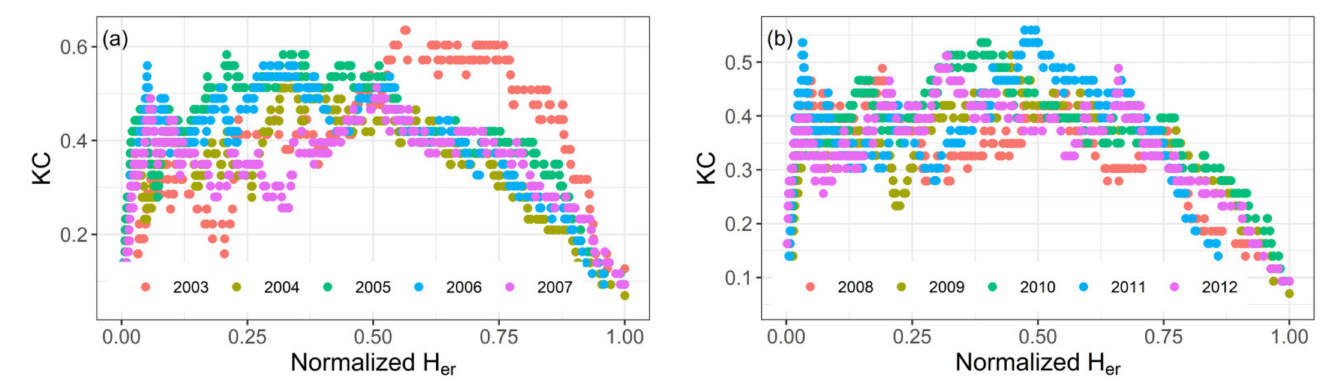
Figure 7. Kolmogorov complexity spectra of the daily H er time-series in Novi Sad for ( a ) period 2003-2007 and ( b ) period